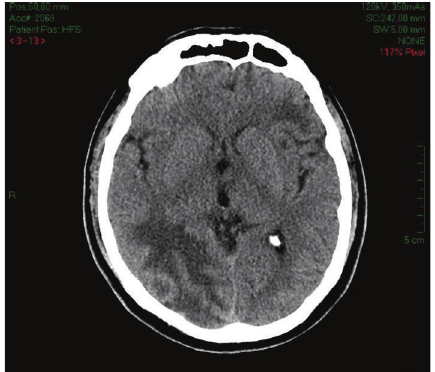
Figure 3: Cystic metastasis. Hypodense, well-demarcated parietal lesion with surrounding digitiform oedema revealed by native CT scan. Department of Neurology, Colentina Clinical Hospital brain imaging